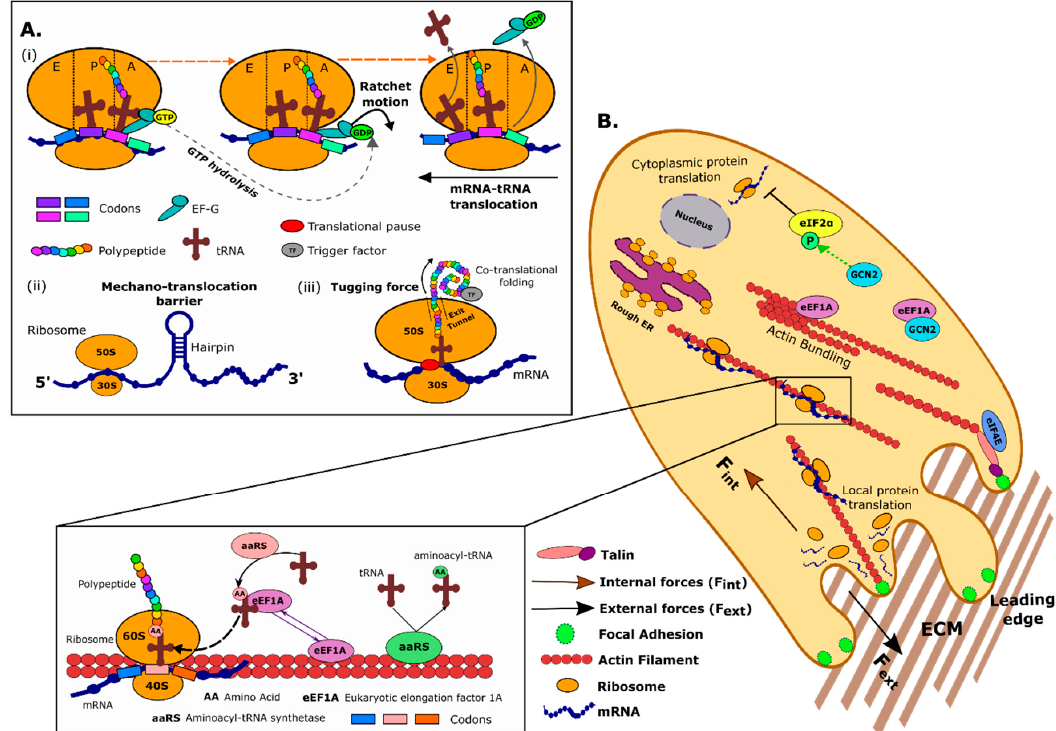
Figure 1. Mechanics in protein translation. ( A ) Schematic of role of forces in prokaryotic protein translation. (i) Forces are generated during the ratchet motion—a molecular motion that moves the tRNA and mRNA so that the next codon in sequence can be read. (ii) Force is required to unwind downstream mRNA hairpins, that act as a mechano-translocation barrier, and allow ribosomes to decode the codon sequence hidden within. (iii) Tugging forces also occur on the polypeptide chain as it pauses. ( B ) In eukaryotic cells, forces can be generated internally, i.e., by the dynamic